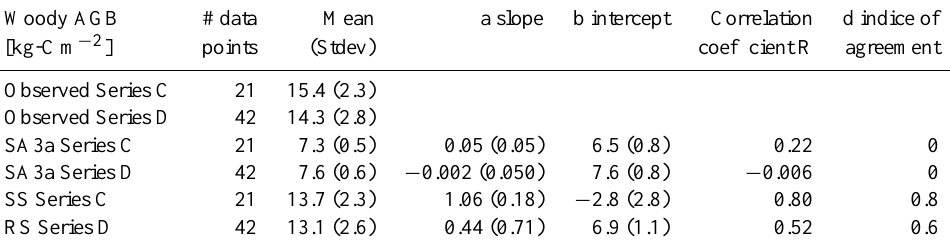
Table 4. Statistical summary of the comparison of wood above-ground biomass between IBIS-simulated results and field estimates. The table presents the number of data points within the studied area, mean and standard deviation, regression slope, intercept and correlation coefficient, and index of agreement (d). The statistical analyses were made for all sites excluding three (CUZ, CHN and AMB, in Supplement D). The statistical analyses were divided in groups of data point as follows: Series C and D represent the series of all data points that have available AGB w field information; Series C represents the series of data where the woody residence time was estimated based on field information; and Series D represents all other data points where AGB w field was known and woody residence time was extrapolated based on the methodology described in this work. Woody AGB # data Mean a slope b